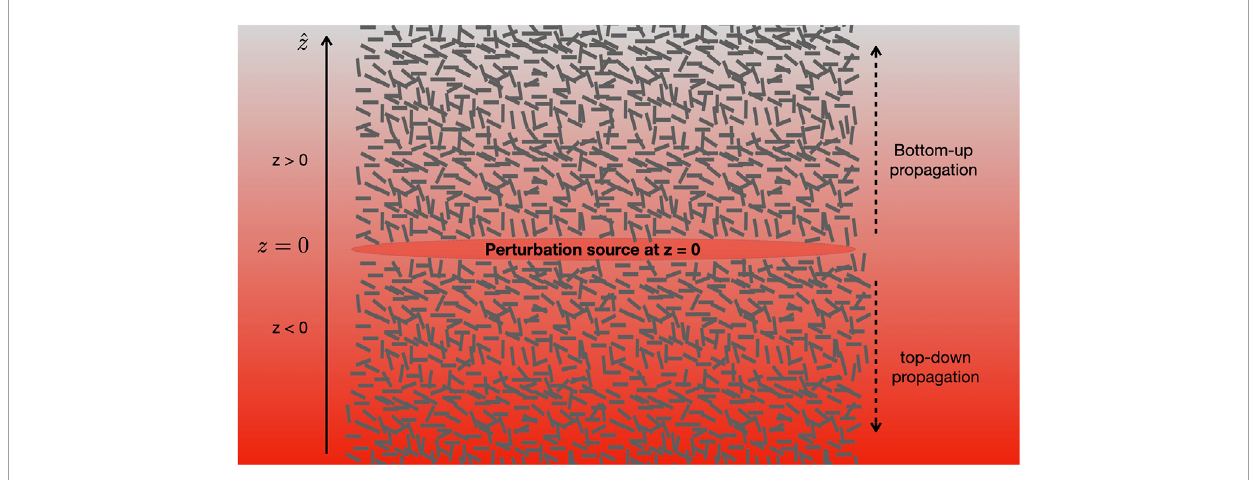
FIGURE 1 Schematic of the 1D crystal mush column. The direction of ̂ z points upward, from hot to cold, against the background temperature gradient. Dashed arrows show top-down and bottom-up transport. Anomalies in temperature and pressure (i.e., magmatic signals) are generated at the source location z = 0, which could propagate in the upper ( z > 0 ) domain or in the lower ( z < 0 ) domain. In the single frequency analysis, results for propagation along both directions are shown; in the broadband perturbation case, one example of bottom-up propagation in the z > 0 region is considered.